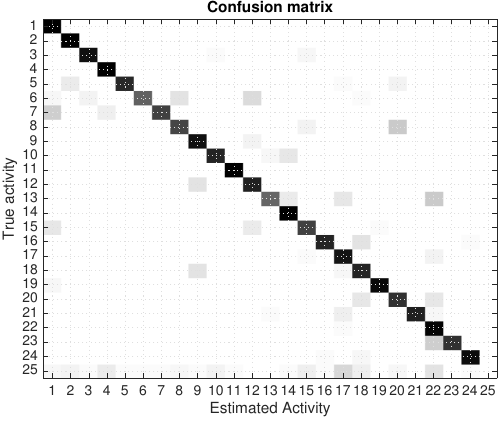
Figure 8. Confusion